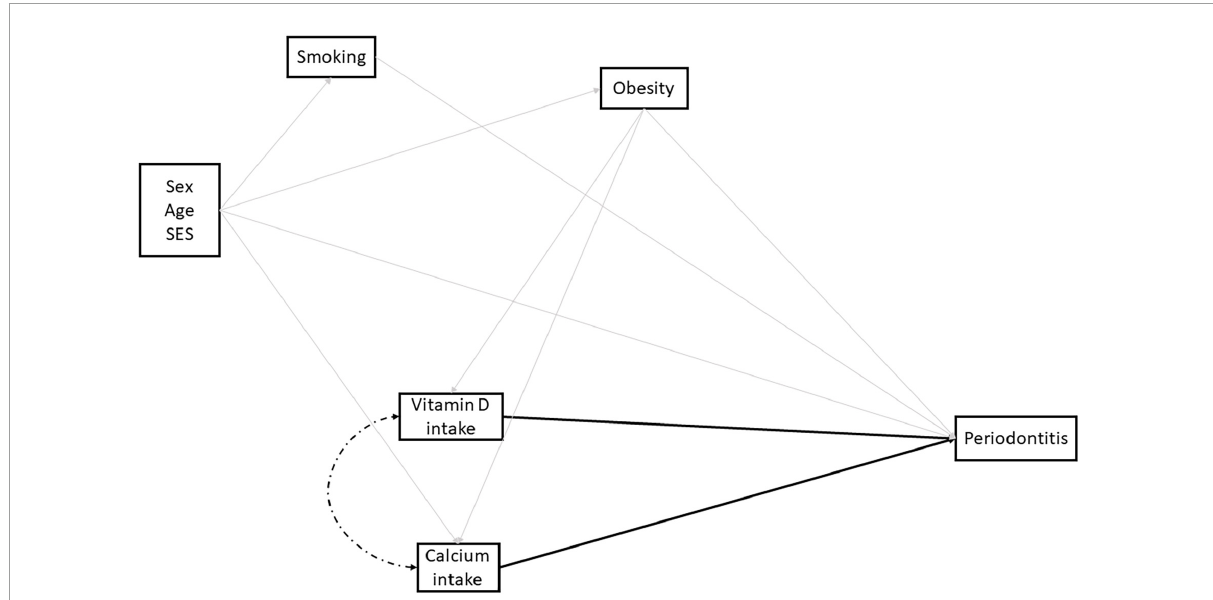
FIGURE2 Directed acyclic graph depicting the relationship between dietary vitamin D and calcium and periodontitis among Brazilian adults. Solid light gray lines indicate potential confounders included in the analysis, whereas solid black lines indicate the direct effect of dietary intake of vitamin D and calcium on periodontitis. Finally, the dashed black line indicates the influence of vitamin D and calcium intake on each other.